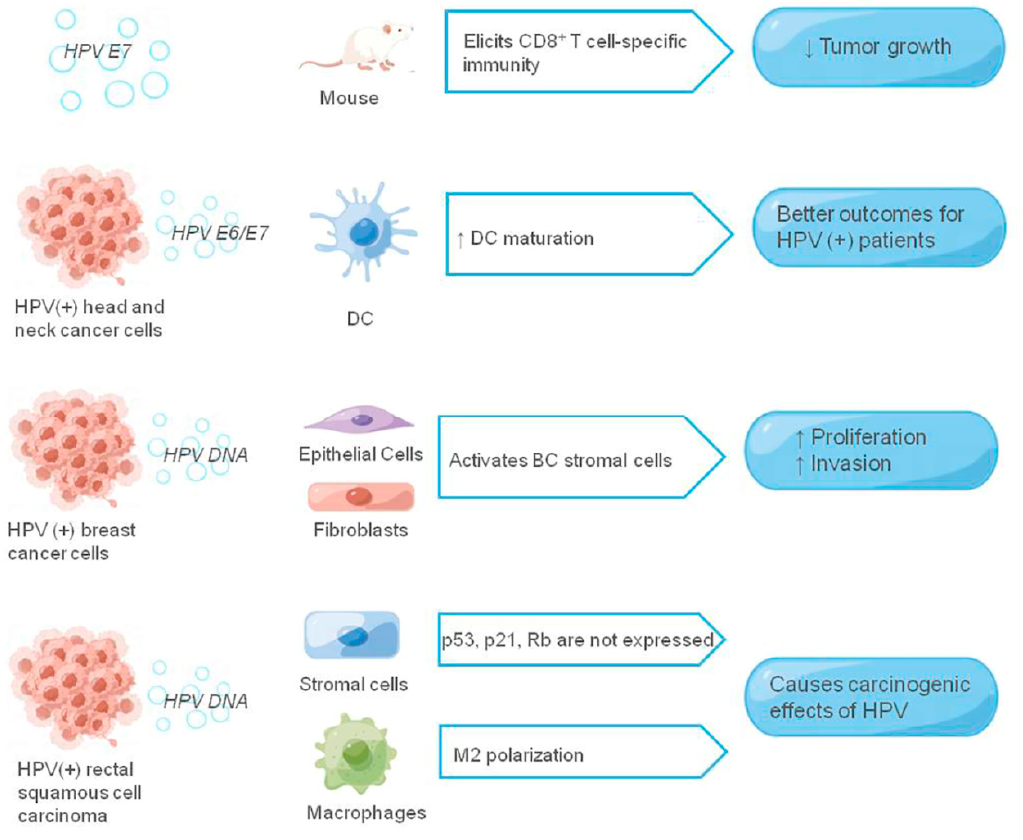
Figure 3. The role of exosomes in the HPV-associated tumor microenvironment. The figure shows the HPV-related components and their receptor cells that function in the exosomes, and the HPV-related components are shown in italics, ↑ means promotion, ↓ means inhibition.